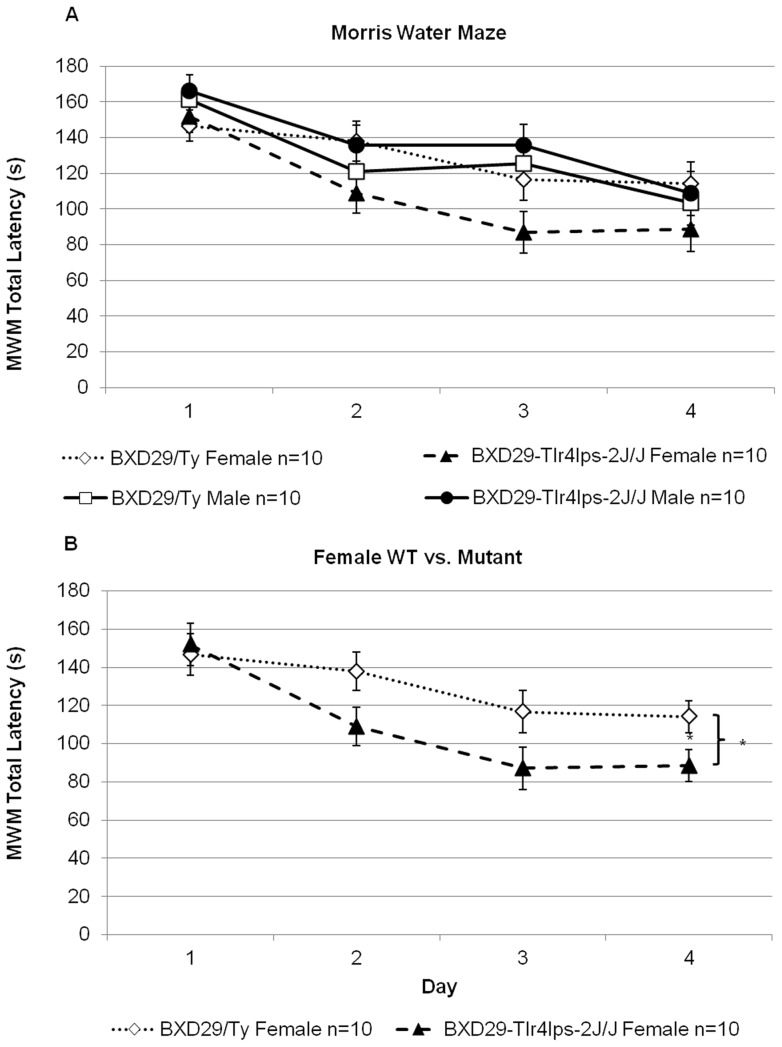
Morris water maze performance of BXD29-Tlr4lps−2J/J mutant and BXD29/Ty wildtype mice.A) Overall analysis of Morris water maze performance revealed a main effect of Sex and Sex × Strain interaction. B) Further post-hoc analysis indicated that the main effects of Sex and Sex × Strain interaction were pulled by the significantly better Morris water maze performance of female BXD29-Tlr4lps−2J/J mutant mice in comparison to both male BXD29-Tlr4lps−2J/J mutant mice and female BXD29/Ty wildtype mice. *P<0.05.